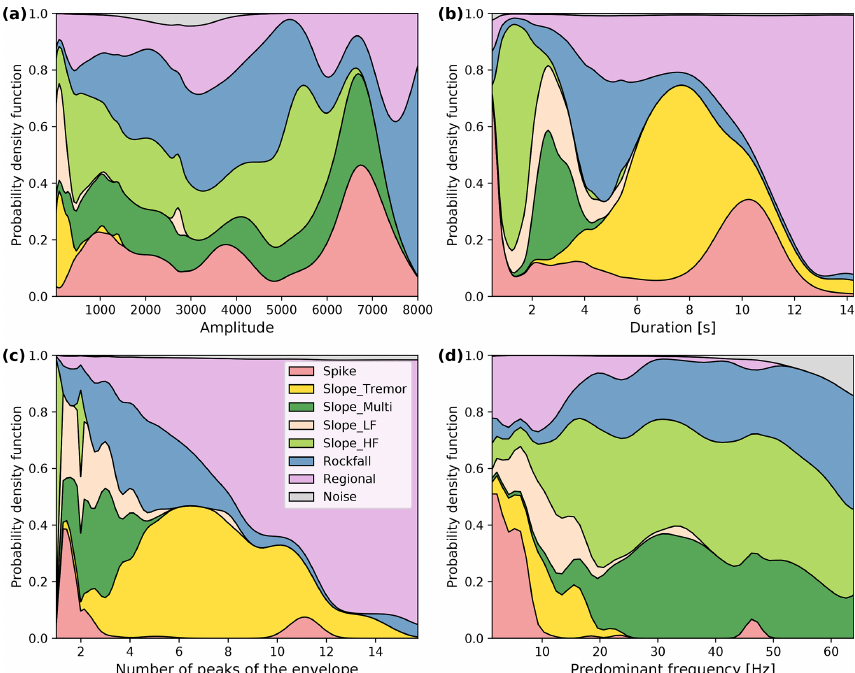
Figure B18. Probability density functions of some extracted features from the training set. Although the CNN is not a feature-based algo- rithm, it is interesting to look at the distribution of those features since they are the ones that a human eye would subconsciously catch and analyse while manually labelling the